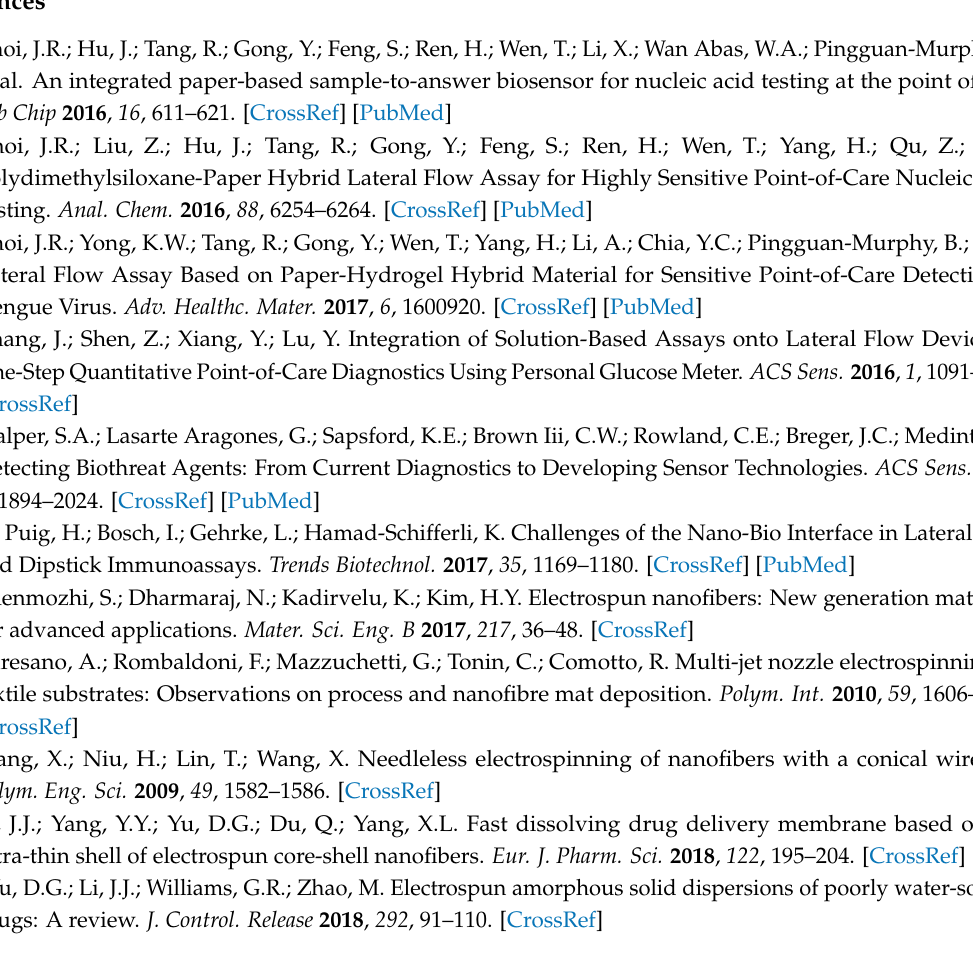
Figure S1: Effect of extremely high NaOH concentration on electrospun PCL nanofibrous membrane, Figure S2: Surface morphology of PCL and hydrolyzed electrospun nanofibers at different concentrations and durations, Figure S3: Effect of 70% ethanol soaking on the surface morphology of hydrolyzed electrospun PCL nanofibers, Figure S4: Thickness of the electrospun PCL nanofibers membrane after treatment of NaOH, Figure S5: The influence of NaOH treatment duration upon wetting and wicking parameters, Figure S6: Wicking properties of the test strips with unoptimized hydrolyzed electrospun PCL nanofibers, Figure S7: The effect of duration of NaOH treatment on the performance of lateral flow assay (LFA) integrated with hydrolyzed electrospun PCL nanofibers for the detection of zika viral DNA, Figure S8: ATR-FTIR absorbance spectra of electrospun PCL plotted against electrospun PCL treated with 2 M NaOH solution for 1.5 h, Table S1: Details of the DNA probes and target